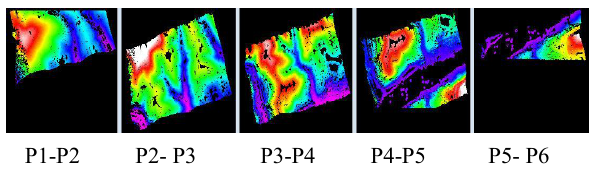
Figure 5. image matching points